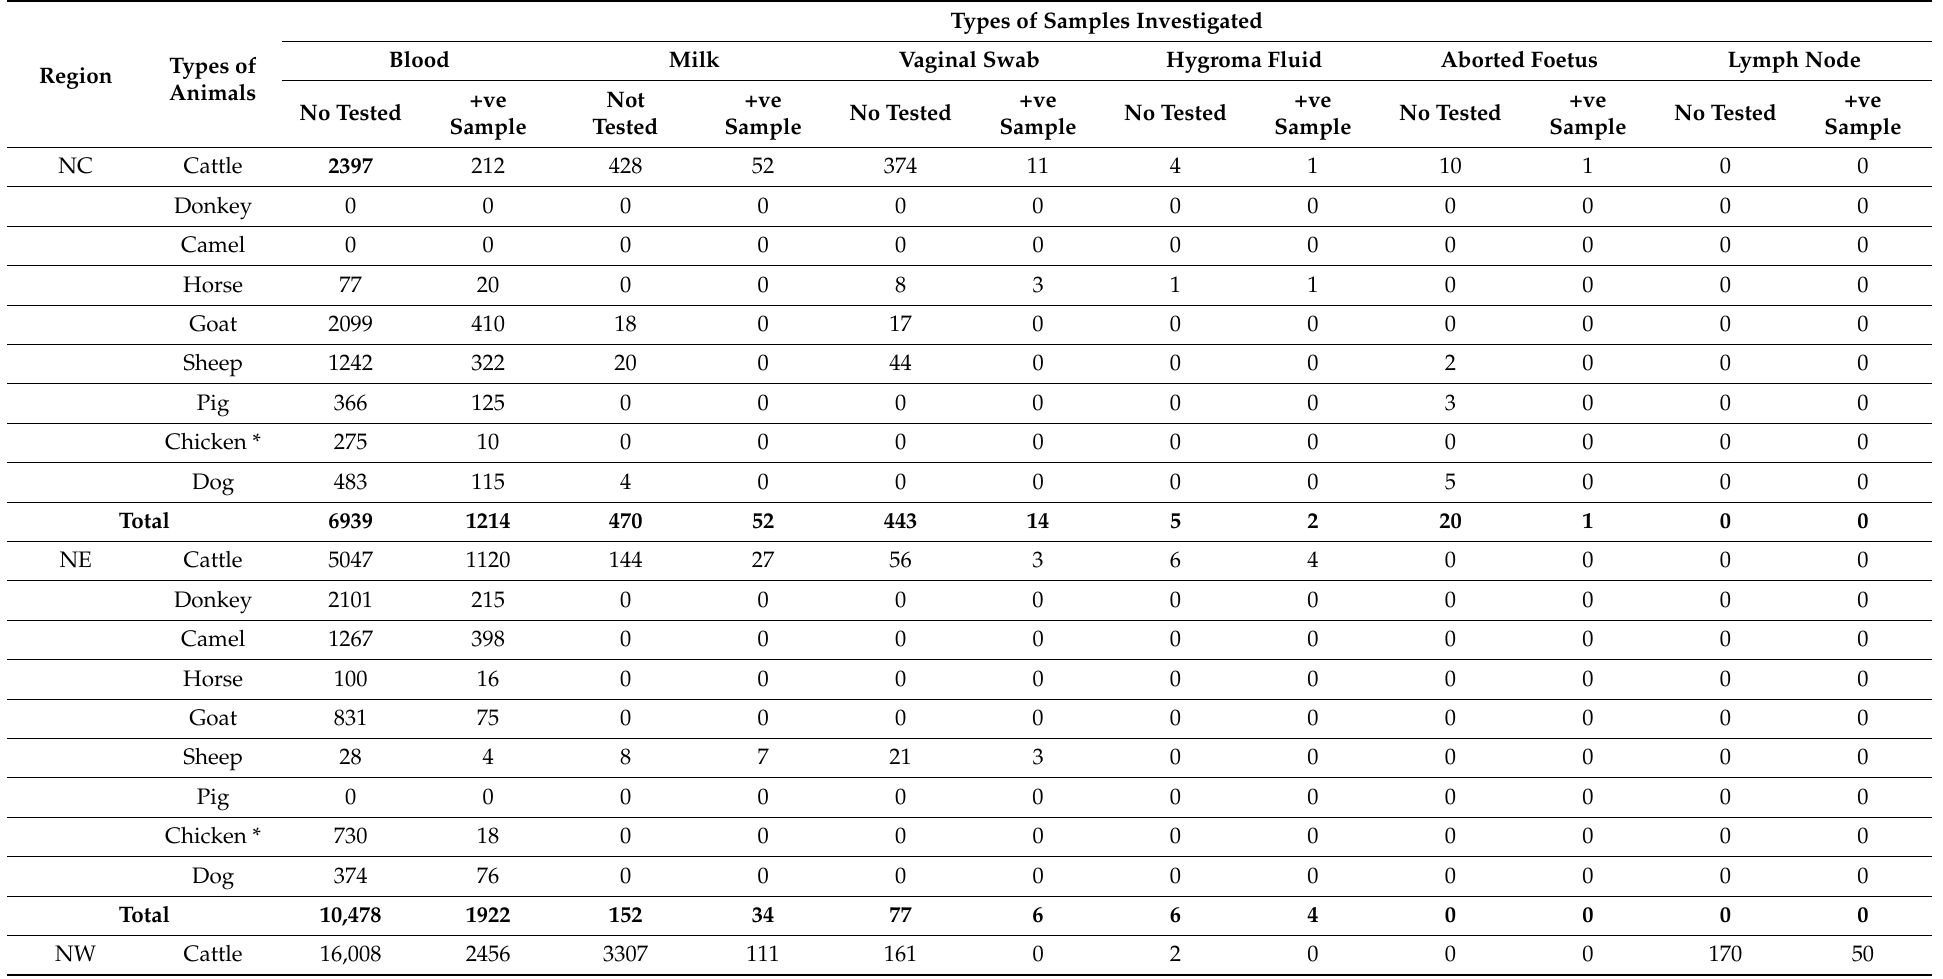
Table 3. Regional distribution of reported cases of Brucella infection in different samples obtained from common domestic animals in Nigeria (2001–2021).